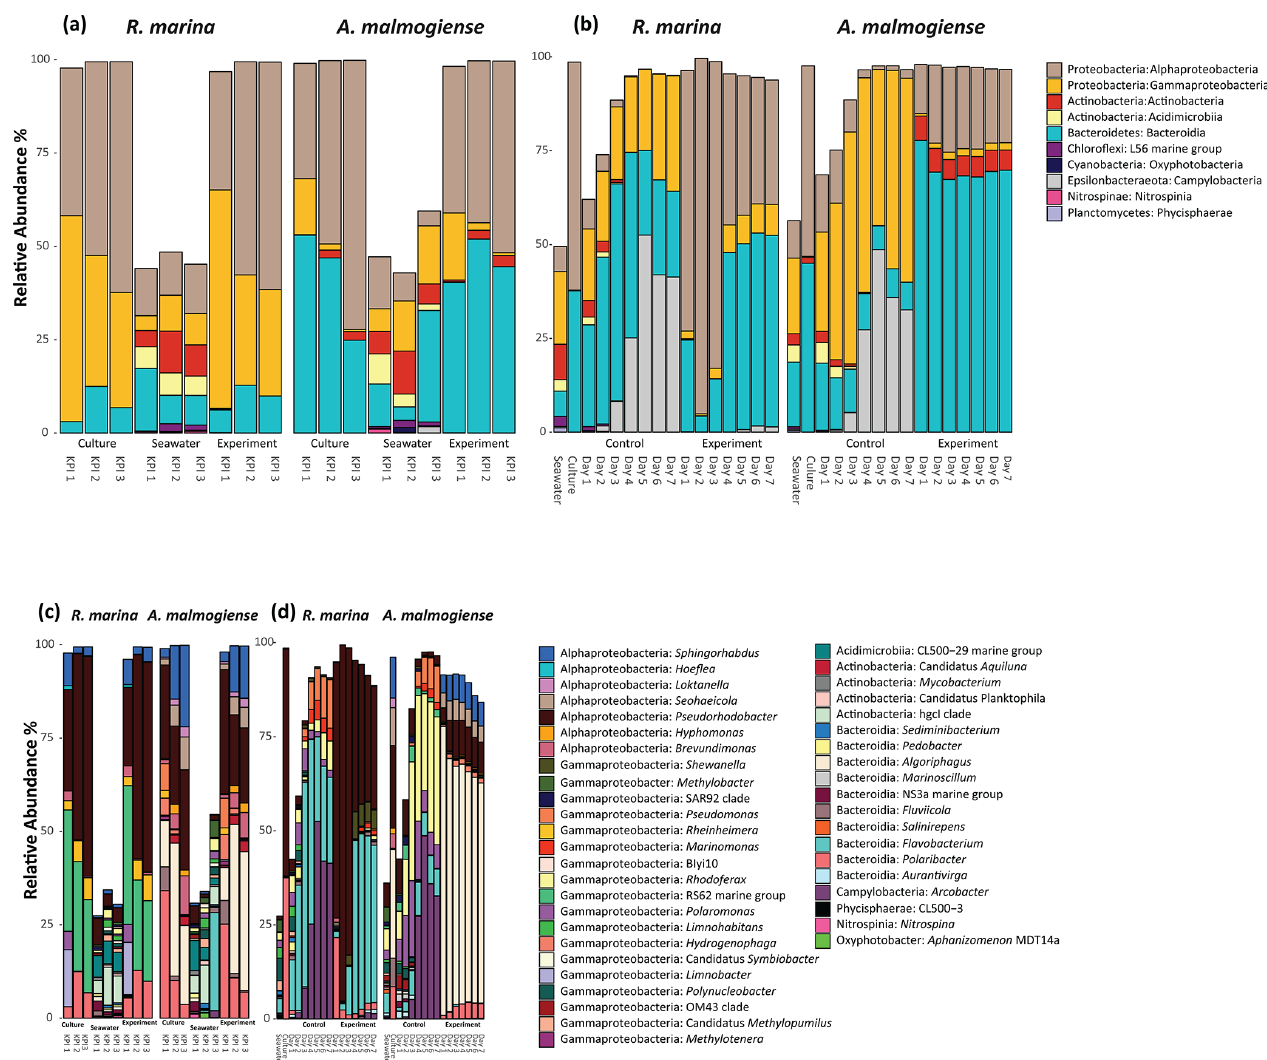
Figure 6. Class-level (upper panels) and genus-level (lower panels) bacterial diversity of 16S ribosomal RNA (rRNA) gene sequences repre- senting > 1% of all amplicon sequence variants (ASVs) in the DOM release experiment (a, c) and in the DOM consumption experiment (b, d) . (a, c) The bars labeled control refer to cultures before the addition of bacterial inoculum. (b, d) The bars labeled control refer to the control treatments (F/2 + seawater